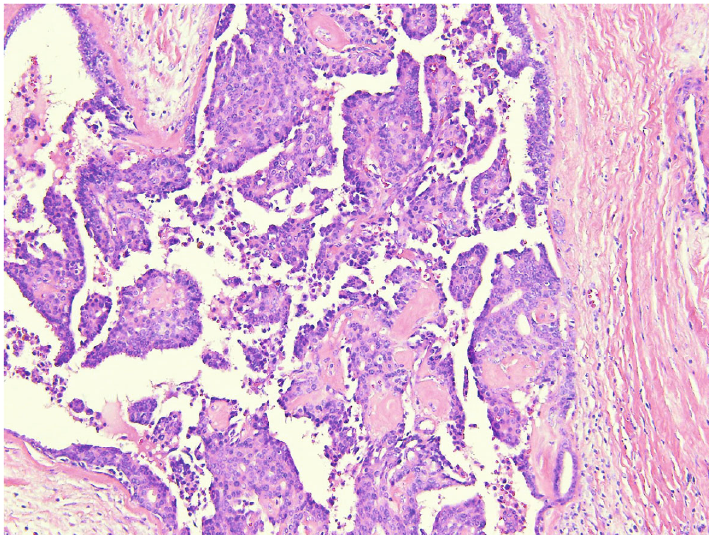
Figure 3: Hematoxylin and eosin stain and intracystic papillary carcinoma (10x magni fi